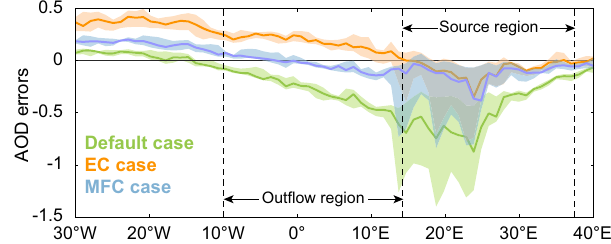
Fig. 6 | Modelled aerosol optical depth (AOD) errors in the source and out fl ow region of Southern Hemisphere Africa by ECHAM-HAM model. All the simula- tionsarecollocatedandcomparedwithPOLDERsatelliteAODdata 43 duringthe fi re season.Simulationsareperformedinthree cases:1)defaultcase,2)EC case,where we only increase the emissions in the source region to match AOD observations; and 3) MFC case, where we modify the emission, precipitation (for correcting lifetime), and particle size (for correcting MEC). The results are shown as the median(solidlines)andinterquartile(shadedareas)oftheseasonalAODerrorsfor all grid cells within the latitudinal range shown in Supplementary Fig. 6. Details about the three cases can be found in